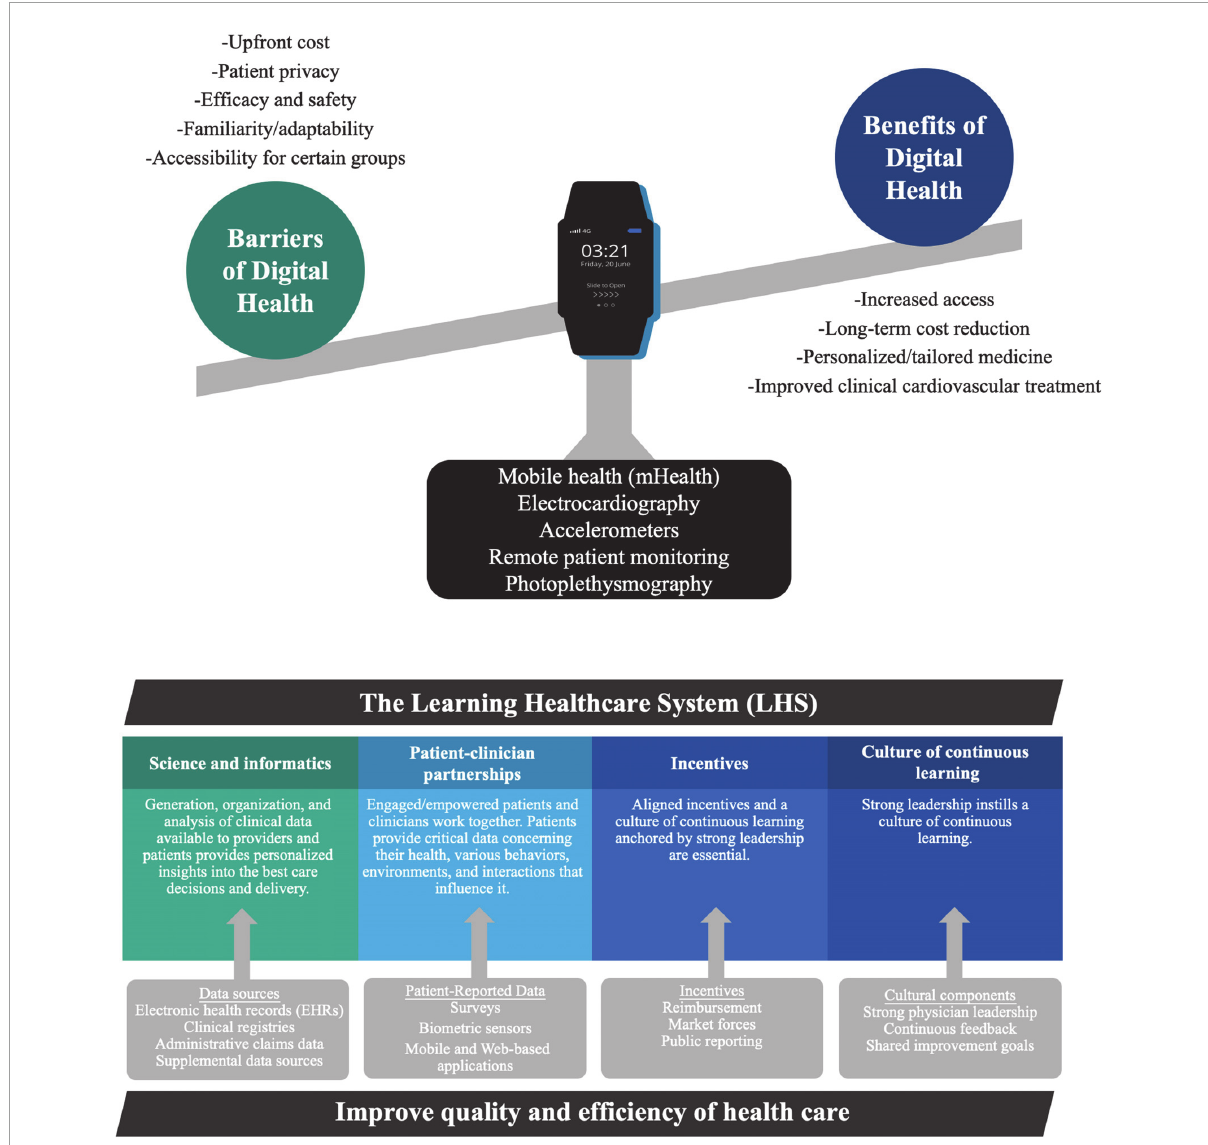
FIGURE1 Digital health architecture and pillars of the learning healthcare system. The digital health architecture provides clinicians with insight into patients’ health and lifestyle outside of healthcare settings. Patient-reported data is recorded with: mobile health (mHealth), biometric sensors (including wearables), and web-based applications. The four key components of the learning healthcare system are data sources, patient-reported surveys, incentives, and cultural components to bolster novel findings and improve quality of care. Templates from Infograpia were used in these